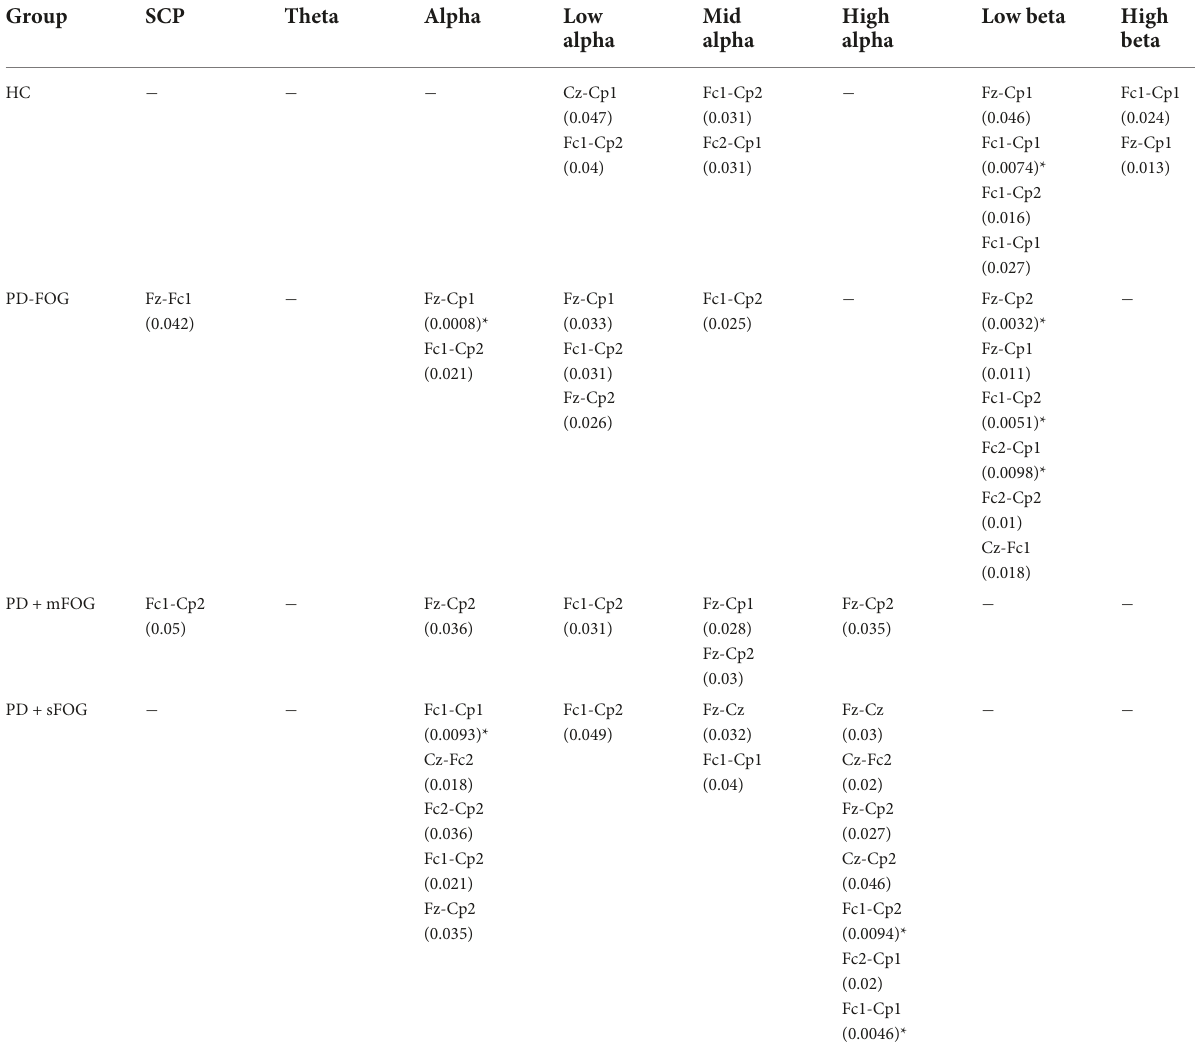
TABLE 3 Pairs of electrodes with significant PLVs over different frequency bands without SL for all groups ( p < 0.05).